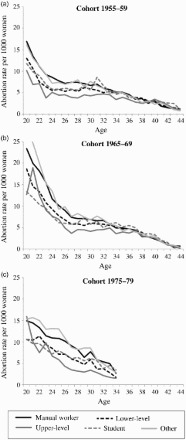
The number of first abortions for social reasons per 1,000 women of the same age and occupational group in Finland